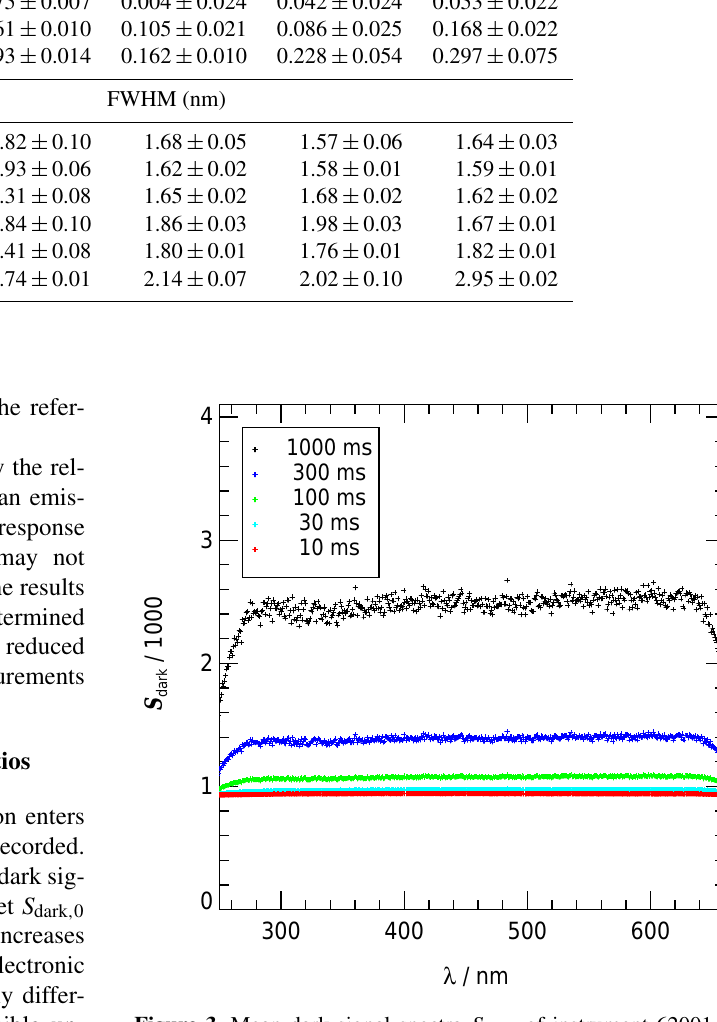
Figure 3. Mean dark-signal spectra S dark of instrument 62001 at different integration times. Dark signals are composed of an elec- tronic background ( S dark , 0 ≈ 900 for this instrument) and a dark- current signal that increases linearly with integration time. Pixel-to- pixel variations represent reproducible structures. The correspond- ing mean noise of the dark signals is comparatively small and listed in Table